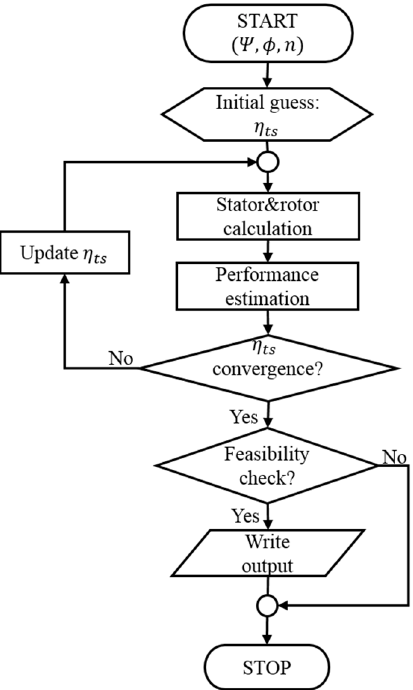
Figure 3. Flowchart of the mean line design process.